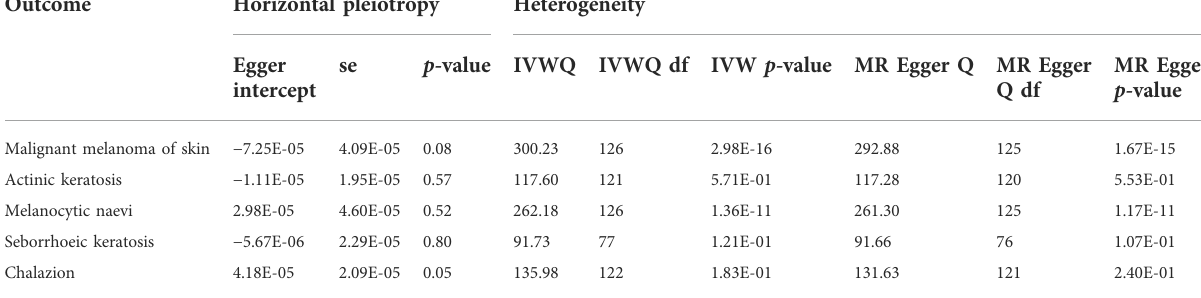
TABLE 6 The results of sensitivity analyses in the replication MR